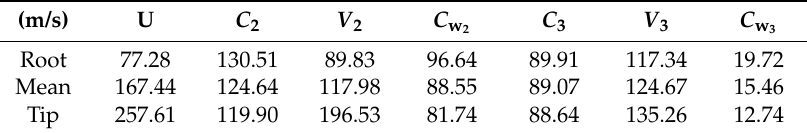
Table 8. Initial angular profile of the stator and rotor blades calculated. Table 7. Velocity vector data collected from preliminary design.